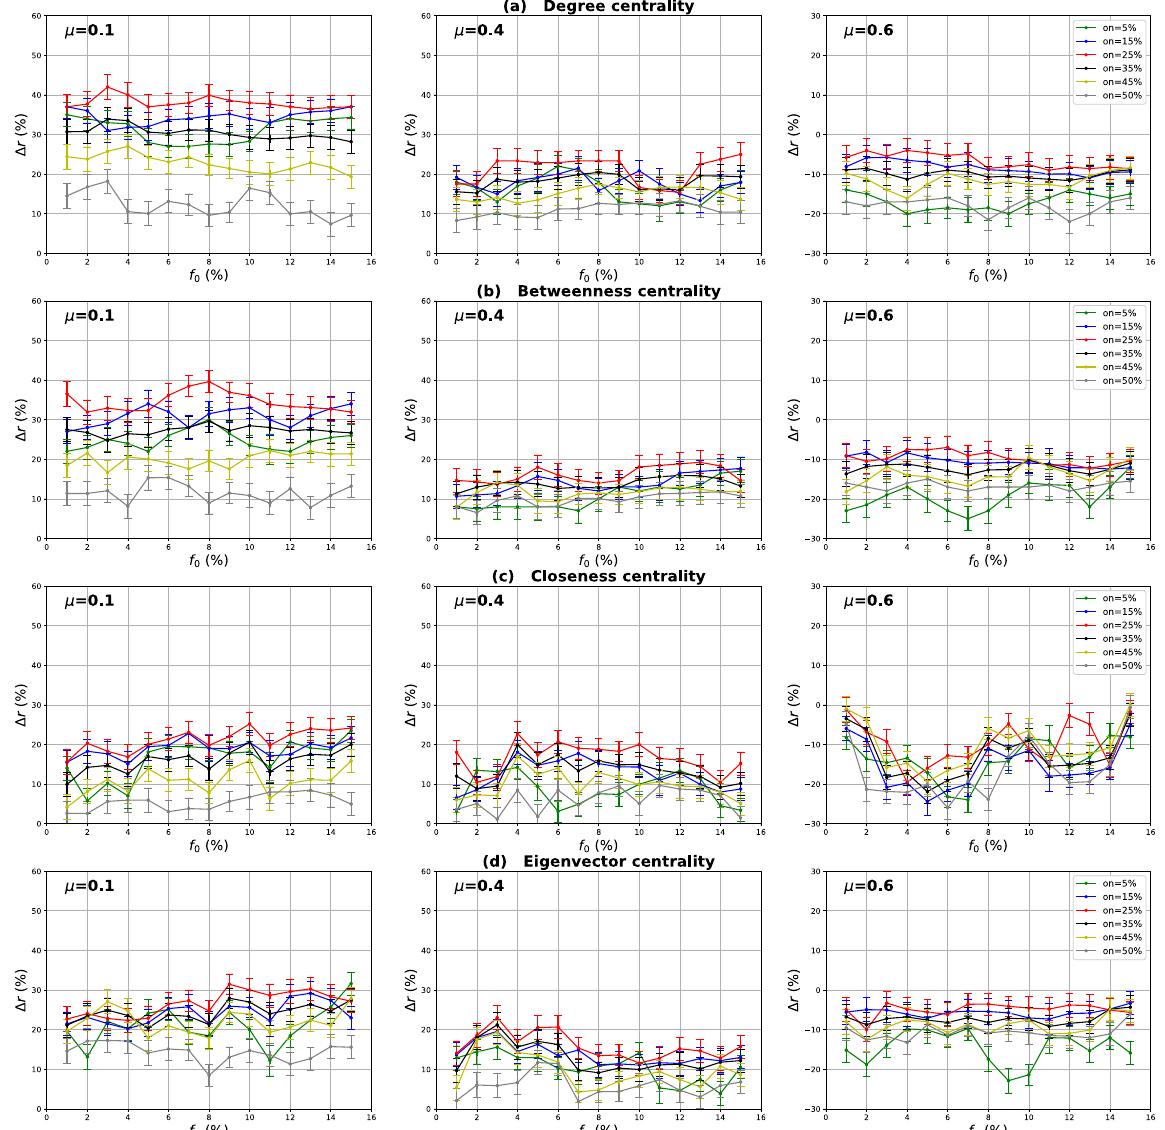
Figure 4. Influence of the number of overlapping nodes. The relative difference of the outbreak size Δ r between the standard measure and the Local measure versus the percentage of initial spreaders f 0 . The community membership value om is equal to 10% of the total number of